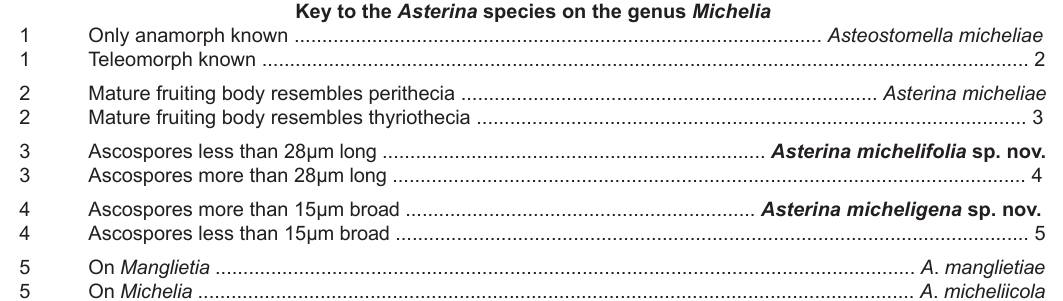
Figure 2. Asterina micheligena sp. nov. a - apprassoriate mycelium; b - thyriothecium; c - ascus; d - ascospores; e - pycnothyriospores